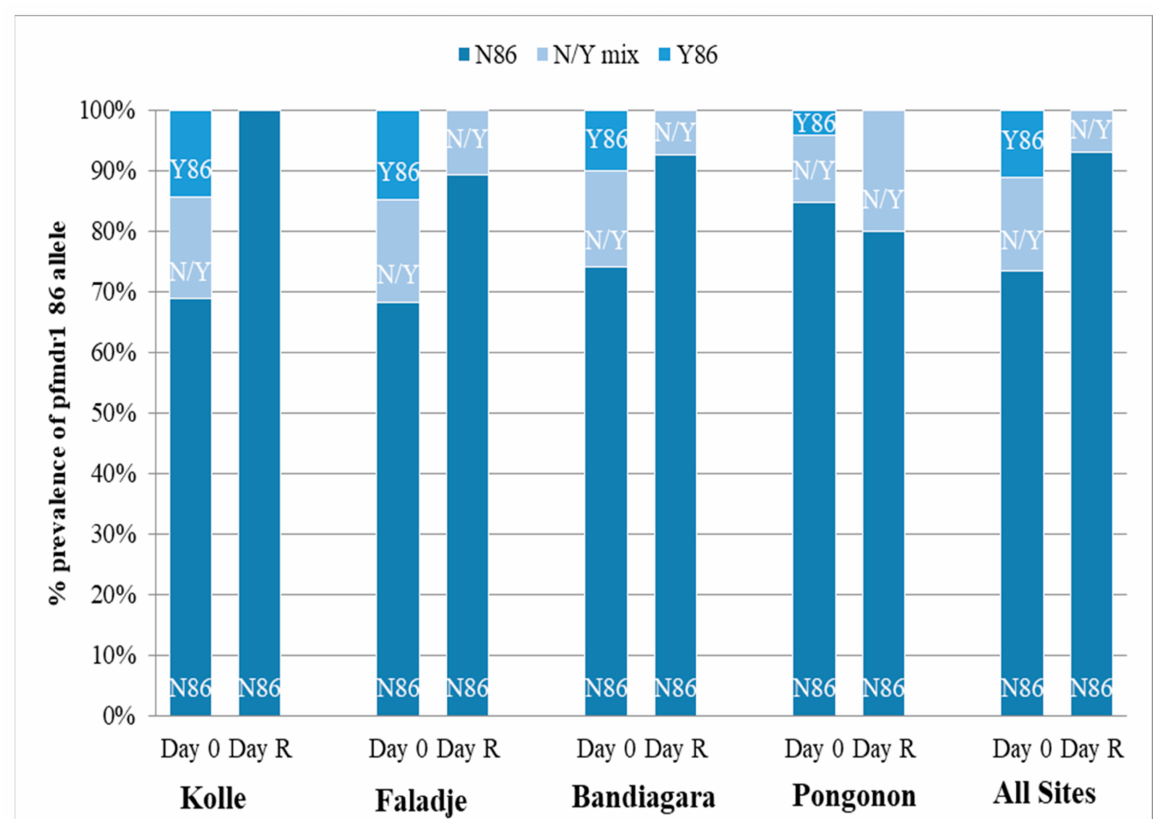
Figure 5. Pfmdr1 allele frequency. D0 = date of enrollment; Day R = date of recurrent infection. Examples of gel photo illustrations for MSP2, MSP1, and Ca1 (Figure 6).